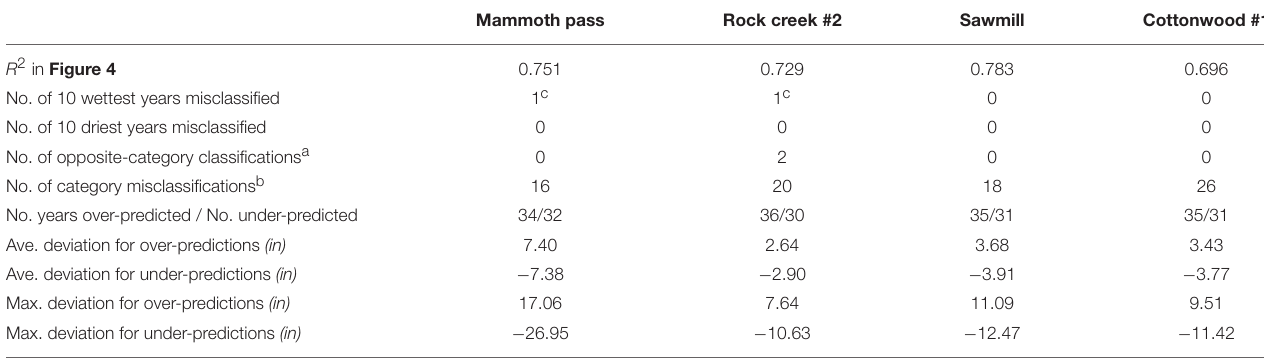
TABLE 1 | Measures of VECM model April 1 SWC forecast